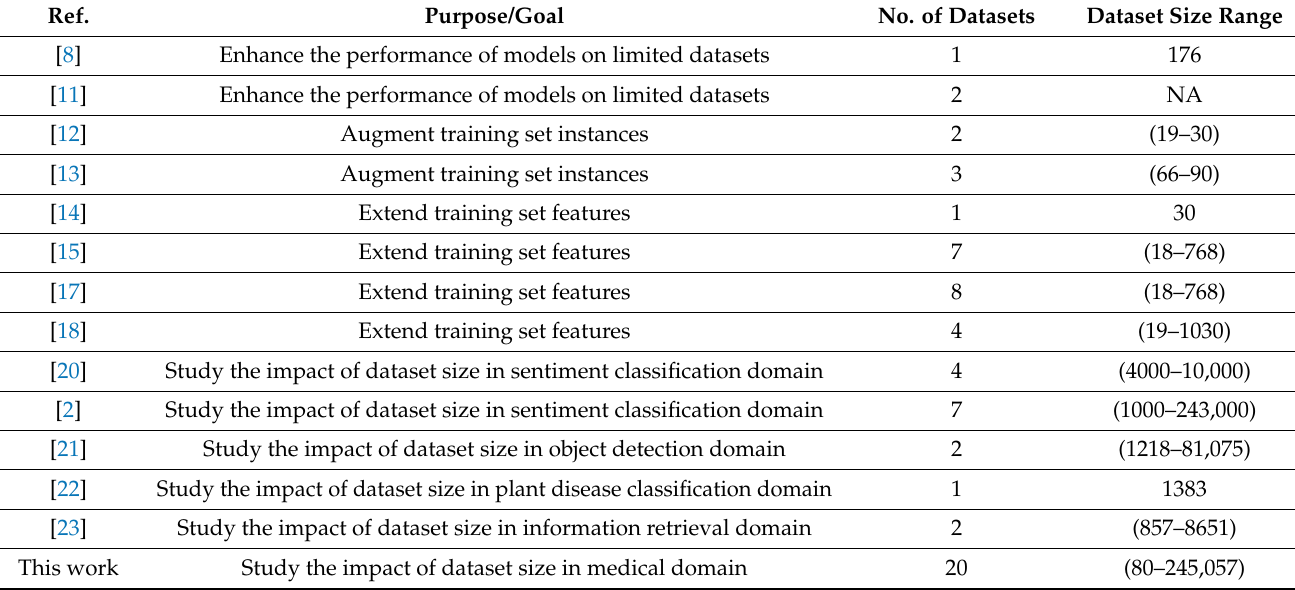
Table 1. Comparison of related